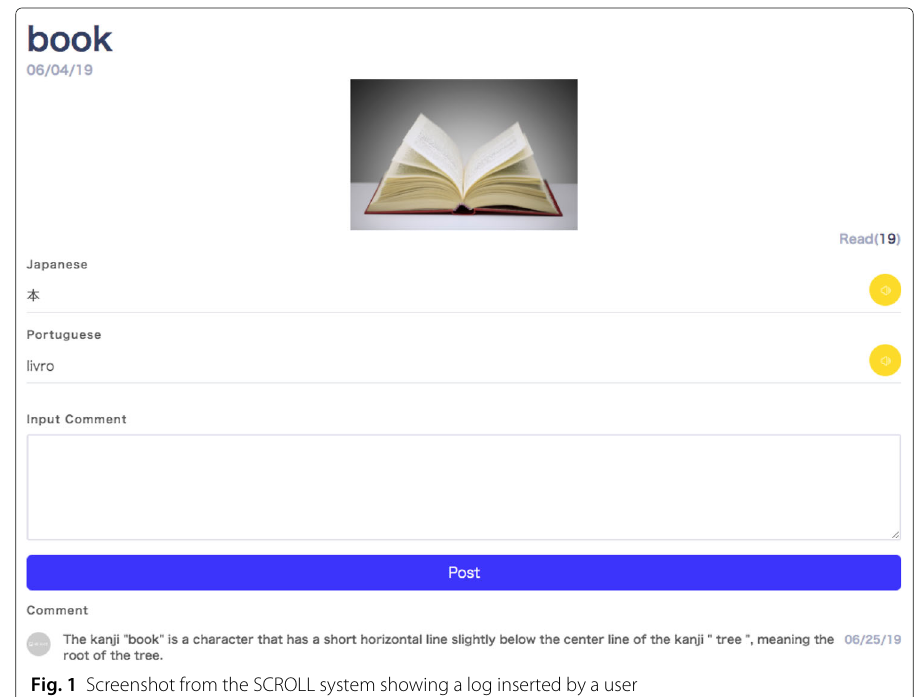
Fig. 1 Screenshot from the SCROLL system showing a log inserted by a user